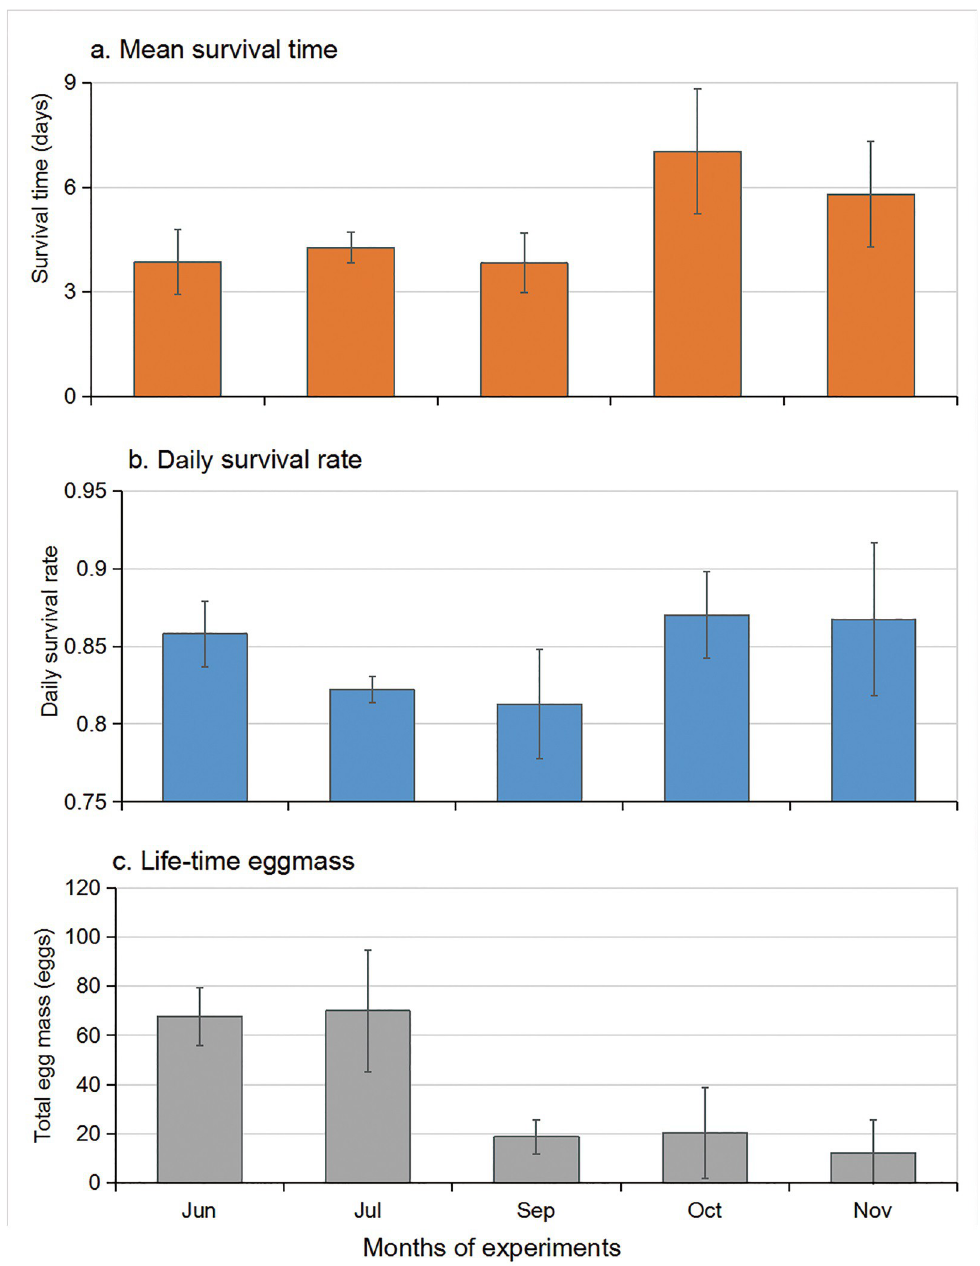
Fig 9. Ae . albopictus adults survival time (top), daily survival rate (middle), and mean life-time egg mass per female (bottom) in different months. June-July experiments were conducted in semi-natural condition and September- November experiments were conducted in semi-field